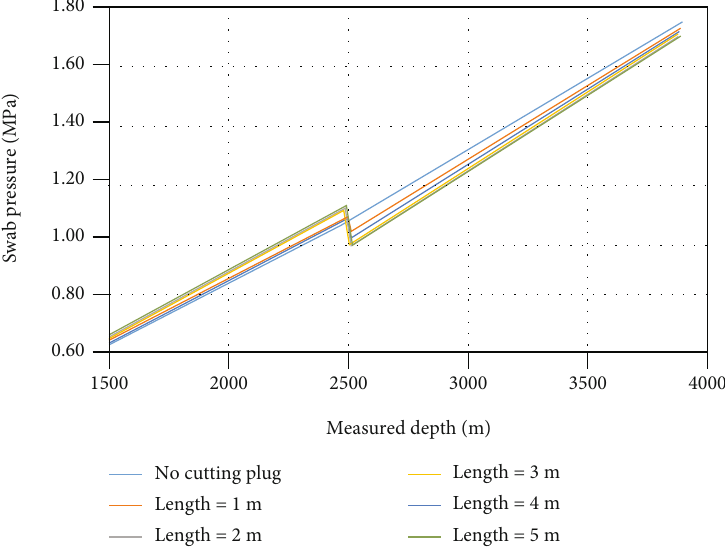
Figure 10: The e ff ect of cutting plug length on the swab pressures in an open pipe